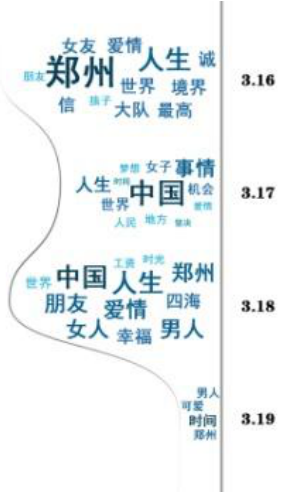
Figure 13. Using a “waterfall“ methaphor to represent tags change over time